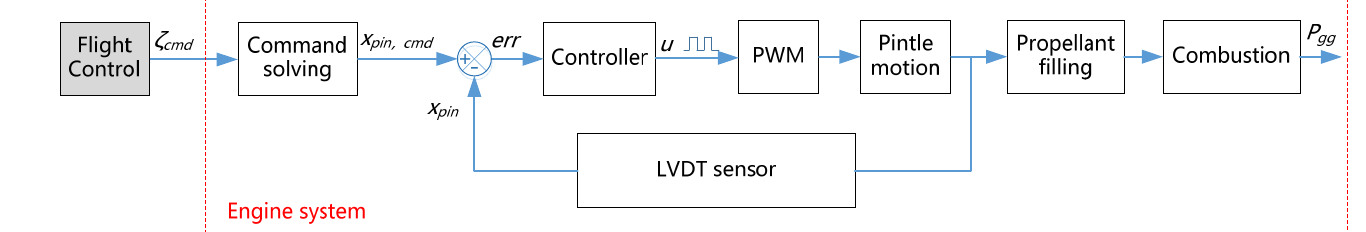
Figure 5. Variable-thrust control system scheme.